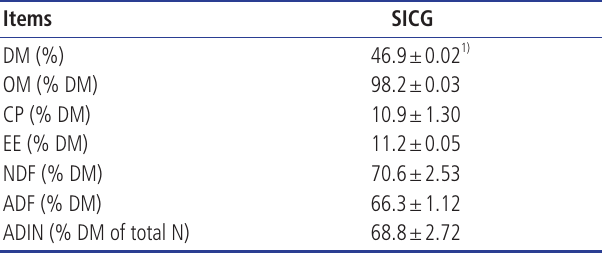
Table 1. Chemical composition of spent instant coffee grounds Items